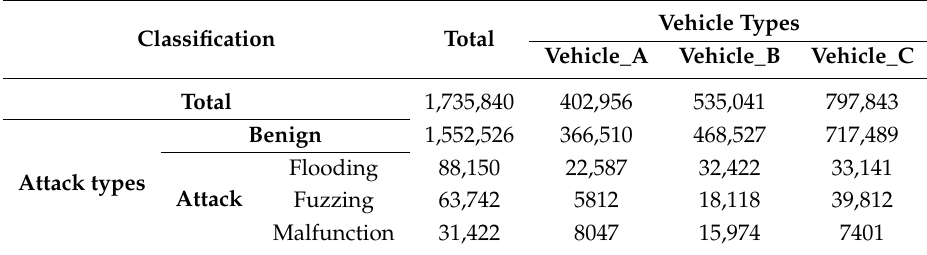
Table 2. Statistics of CAN intrusion